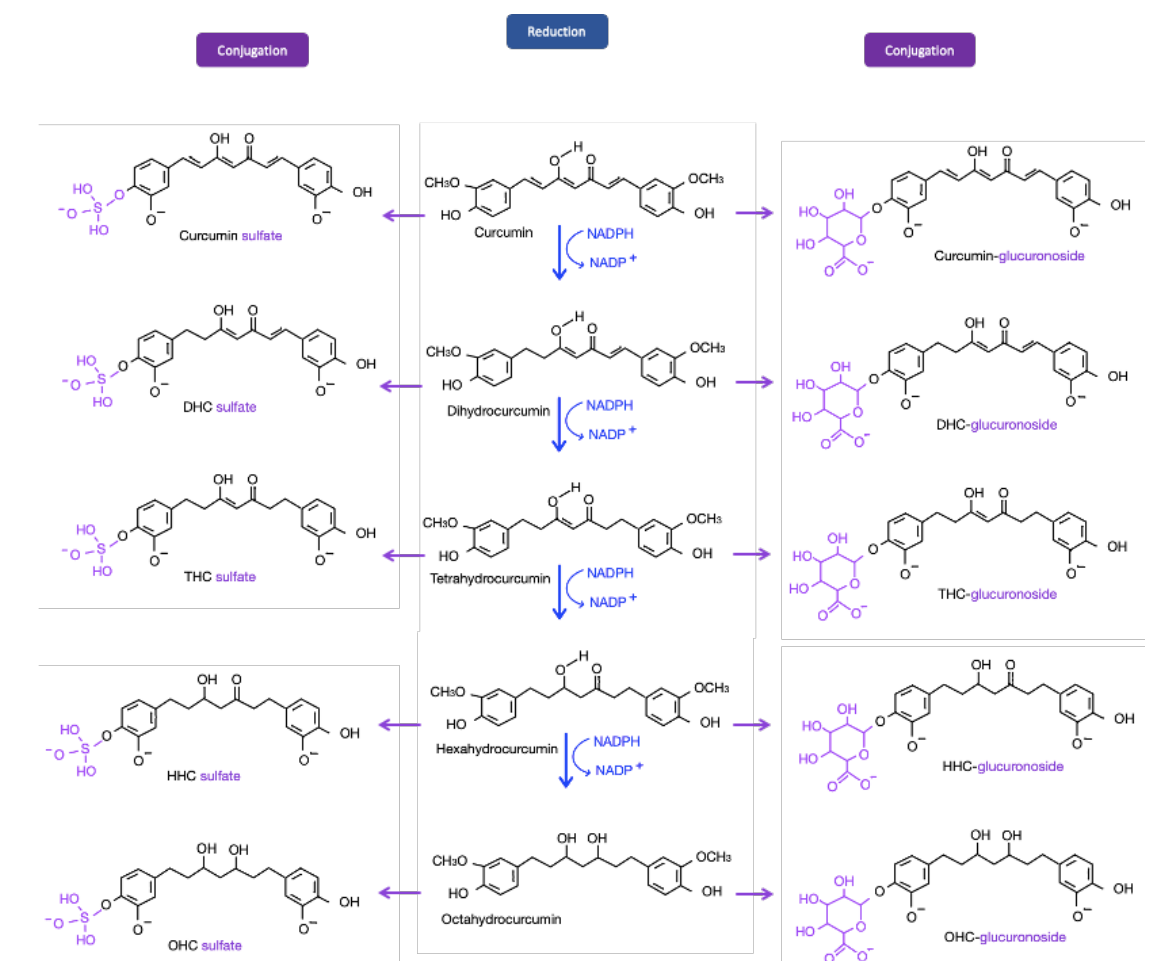
Figure 2. Metabolites of curcumin. After being taken up by enterocytes, curcumin molecules are metabolized. Through reductase, sulfotransferase, and glucuronosyltransferase enzymes, the systemic level of curcumin is reduced. Several metabolites of curcumin are shown; among these metabolites, tetrahydrocurcumin (THC) has been the focus of recent studies and is discussed in later paragraphs. Pathways in blue represent the reductions of curcumin by NADPH; pathways in purple are the conjugations of curcumin and its following reductions.